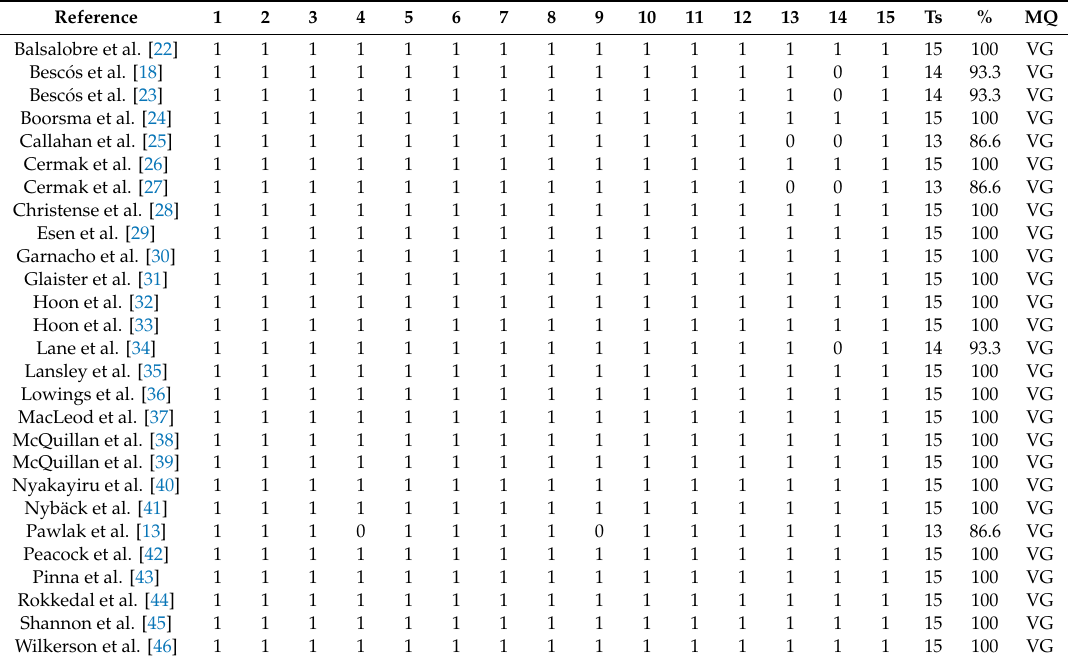
Table 2. Methodological quality of the studies included in the systematic